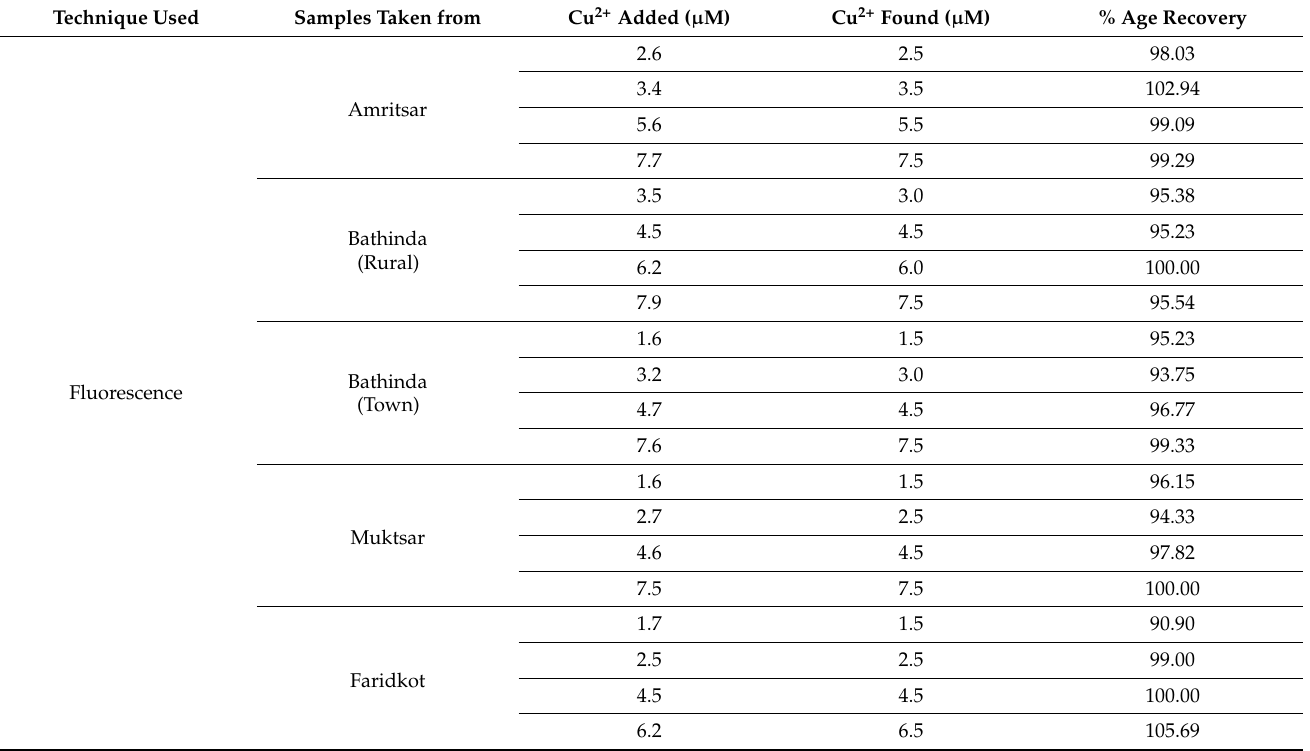
Table 1. Determination of Cu 2+ ions in spiked real water samples taken from different areas of Pun-